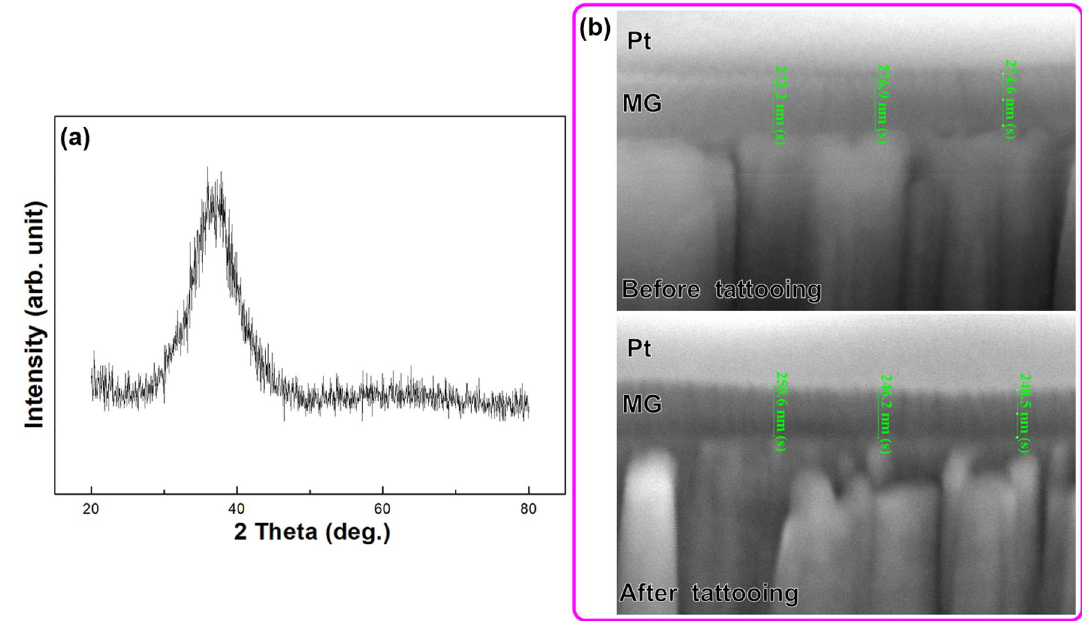
Figure 1. ( a ) XRD crystallographic analysis result of MG coating. ( b ) Cross-sectional SEM micrographs of coated needles before and after tattooing for 25 cm 2 area on a live pig. Cross-sectional samples were sectioned by FIB. Pt as the protective layer was deposited during FIB cutting.